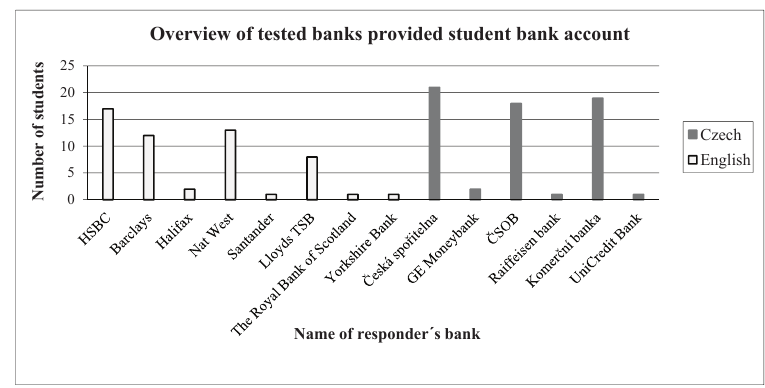
Fig. 1 - Overview of banks provided student bank account. Source: Author´s own.